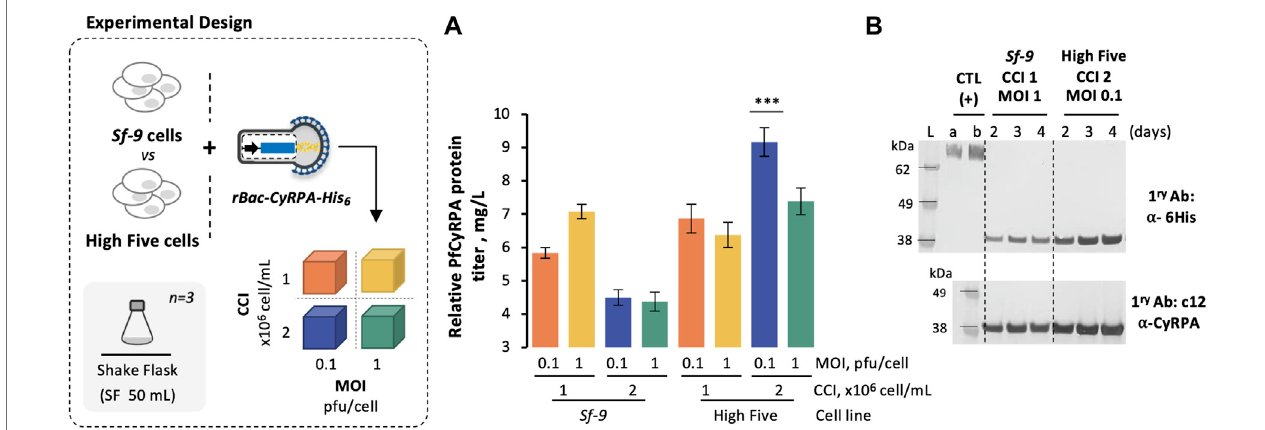
FIGURE 1 | Production of Pf CyRPA using insect Sf-9 and High Five cells. (A) Relative Pf CyRPA protein titer (mg/L), obtained by densitometry analysis of Western blot images. (B) Identi fi cation of Pf CyRPA in culture supernatant samples by Western blot. Positive control (CTL+) is an hsEGFR-His6 protein produced in-house at 50 and 75 ng; Ladder (L) is SeeBlue ™ Plus2 Pre-stained Protein Standard. Data in the bar graph are expressed as mean ± standard deviation (relative to three biological replicates, n = 3). Statistical signi fi cance was tested by one-way ANOVA with Dunnett ’ s multiple comparison analysis methods, comparing the mean of each column to optimal condition (i.e., CCI = 2 × 10 6 cell/mL and MOI = 0.1 pfu/cell, High Five cells); *** = adjusted p -value < 0.001 was considered statistically signi fi